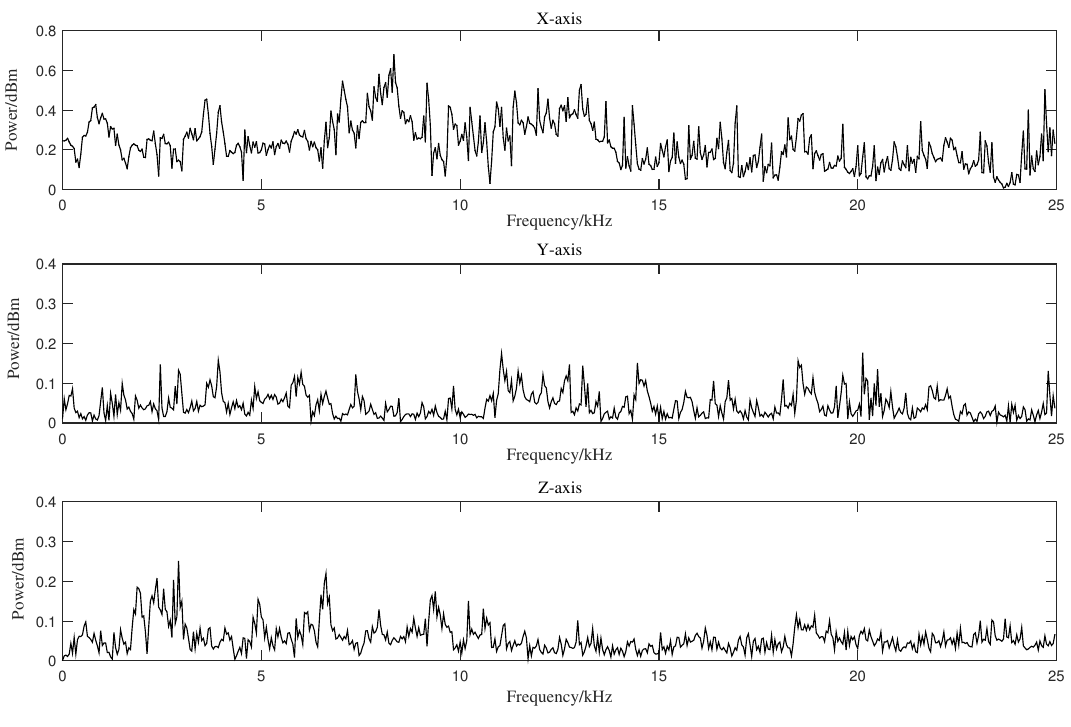
Figure 1. Power-spectrum distribution of activity